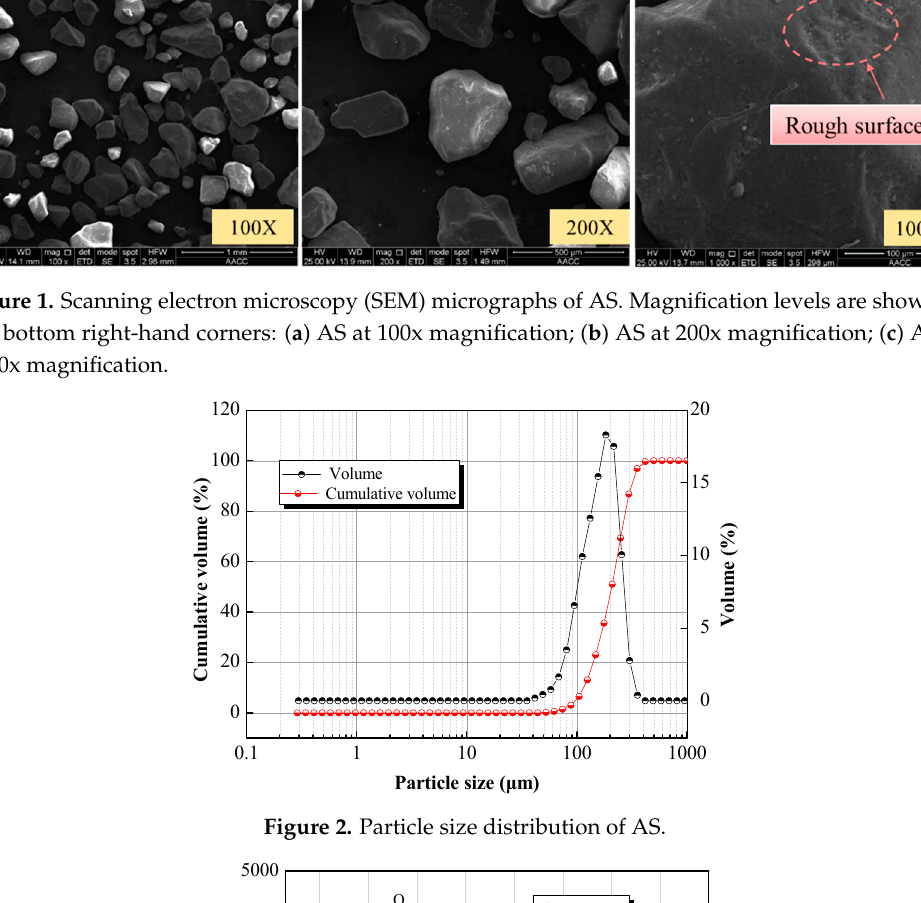
Figure 1. Scanning electron microscopy (SEM) micrographs of AS. Magnification levels are shown in the bottom right-hand corners: ( a ) AS at 100x magnification ; ( b ) AS at 200x magnification ; ( c ) AS at 1000x magnification .